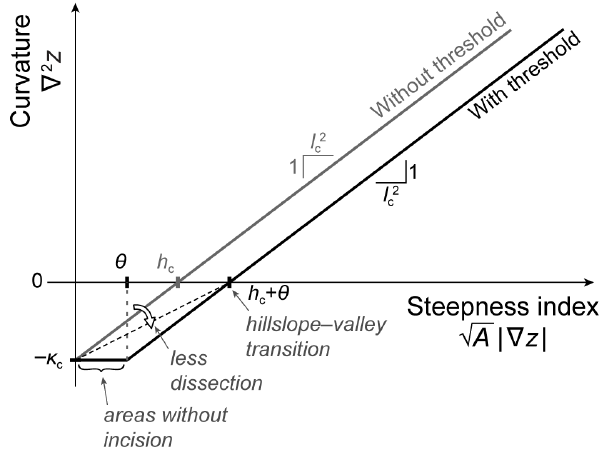
Figure 2. Effects of incision threshold on steady-state topogra- phy as reflected in the curvature–steepness index line. We show curvature–steepness index lines of landscapes with and without an incision threshold using black and gray, respectively (see Eqs. 11 and 12). The gray line in this figure is identical to the line in Fig. 1. Adding an incision threshold to the LEM changes the re- sulting steady-state topography, as indicated by the differences be- tween the gray and black lines. The black line consists of two seg- ments. The horizontal segment corresponds to points where inci- sion is fully suppressed by the threshold. This horizontal segment is at ∇ 2 z = − κ c , which is the vertical-axis intercept of the gray line. This shows that the hilltop curvature (the most negative cur- vature value in the landscape) spreads to points on hillslopes be- yond drainage divides. Thus, hillslopes become more convex due to the threshold. The inclined segment of the black line is par- allel to the gray line and at a horizontal distance θ to its right. Thus, the horizontal-axis intercept is increased from h c to h c + θ due to the threshold; i.e., the hillslope–valley transition occurs at a larger steepness index value. This increase corresponds to a larger drainage area A and/or steeper slope |∇ z | , both of which are con- sistent with the steepening of landscapes and the decrease in their drainage density by the incision threshold. In the case of the LEM that includes an incision threshold, the degree of landscape dis- √ section is expressed by the length scale 1 + N θ l c (see Eq. 21), where N θ is a dimensionless incision-threshold number (Eq. 9). The square of this length scale is (1 + N θ ) l 2 c , which is equal to ( h c + θ ) /κ c , the ratio of the two intercepts of the black line. The quantity (1 + N θ ) l 2 c is the reciprocal of the slope of the black dashed line that connects the two intercepts. Thus, by comparing the slope of this auxiliary line and of the gray curvature–steepness index line, we can graphically express the effect of the incision threshold on landscape dissection, as shown by the white